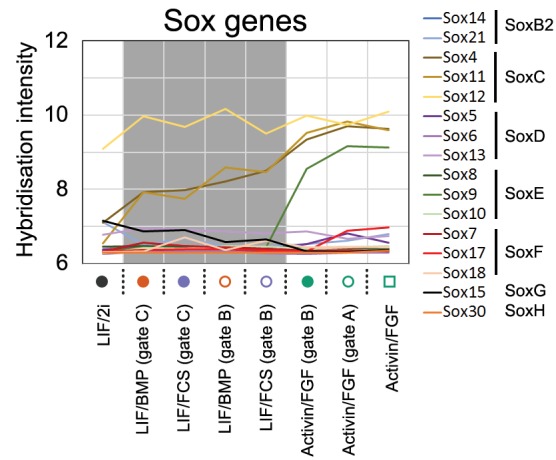
Microarray signal intensity of Sox family members in all sorted populations.Sample legend and culture conditions refer to Figure 1C.